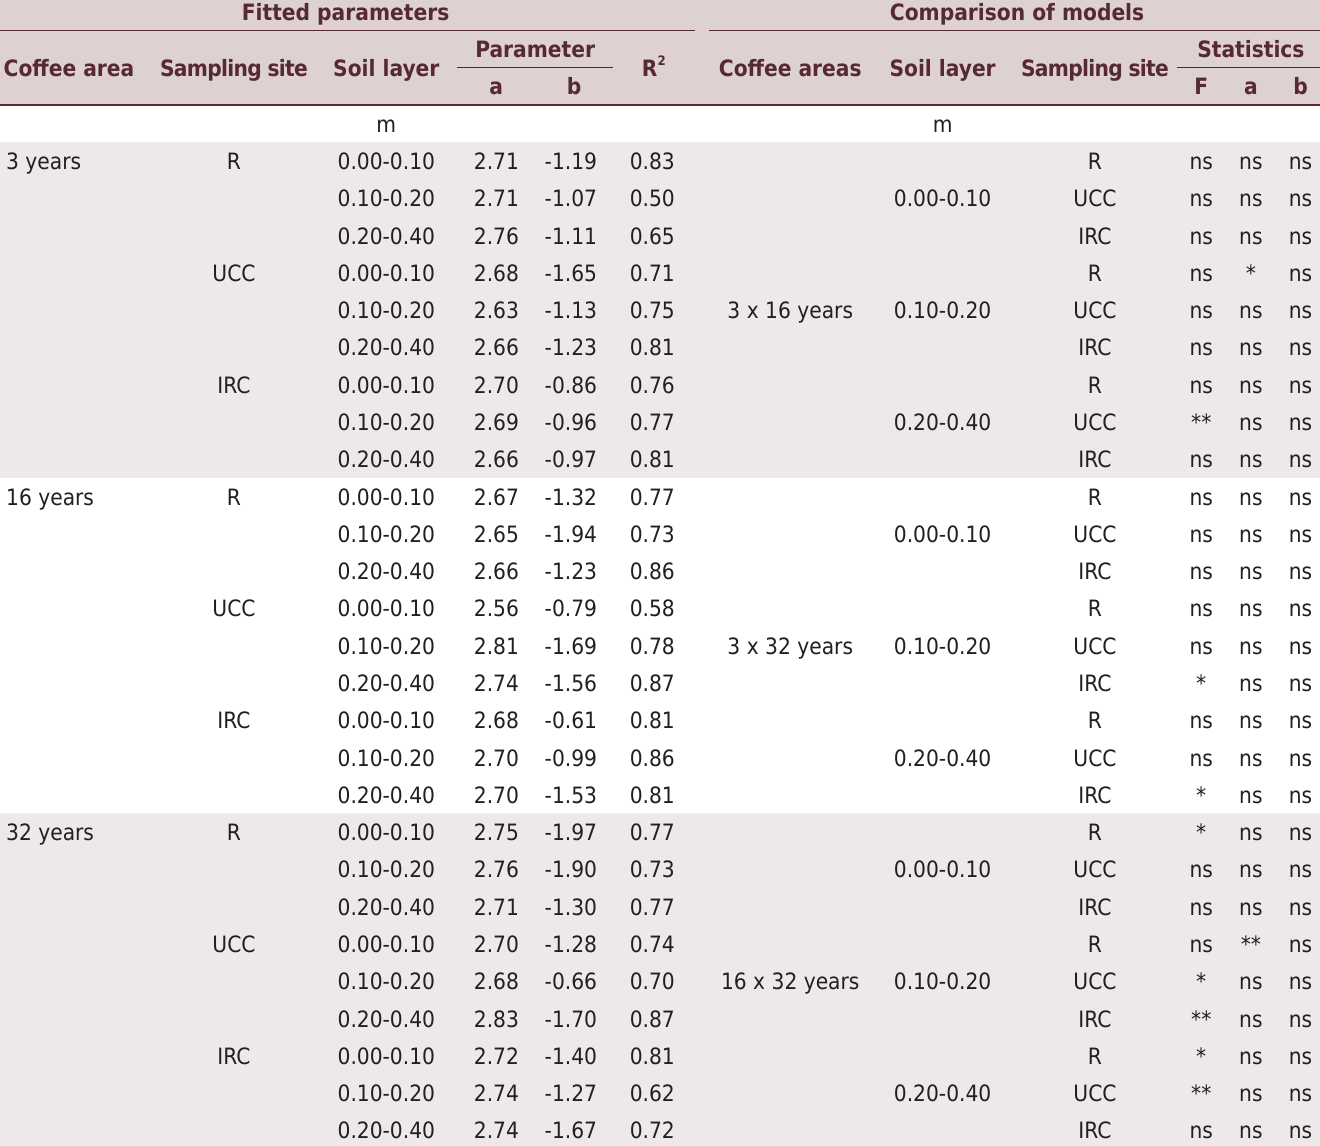
Table 5. Linear “a” and angular “b” coefficients of the soil load-bearing capacity models, in function of gravimetric moisture, and a statistical comparison according to Snedecor and Cochran (1989) for an Ultisol, in areas cultivated with coffee with different deployment times (3, 16, and 32 years), at 0.00-0.10, 0.10-0.20, and 0.20-0.40 m layers, and different sampling